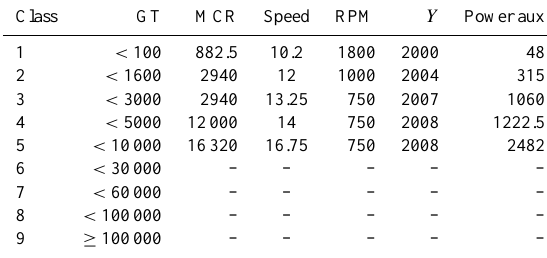
Table A6. Class medians for tugs.